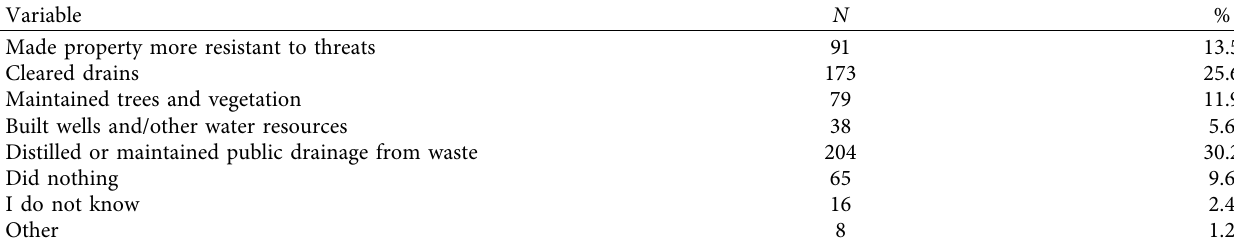
Table 8: Respondents’ adaptation strategies against natural disasters encountered.